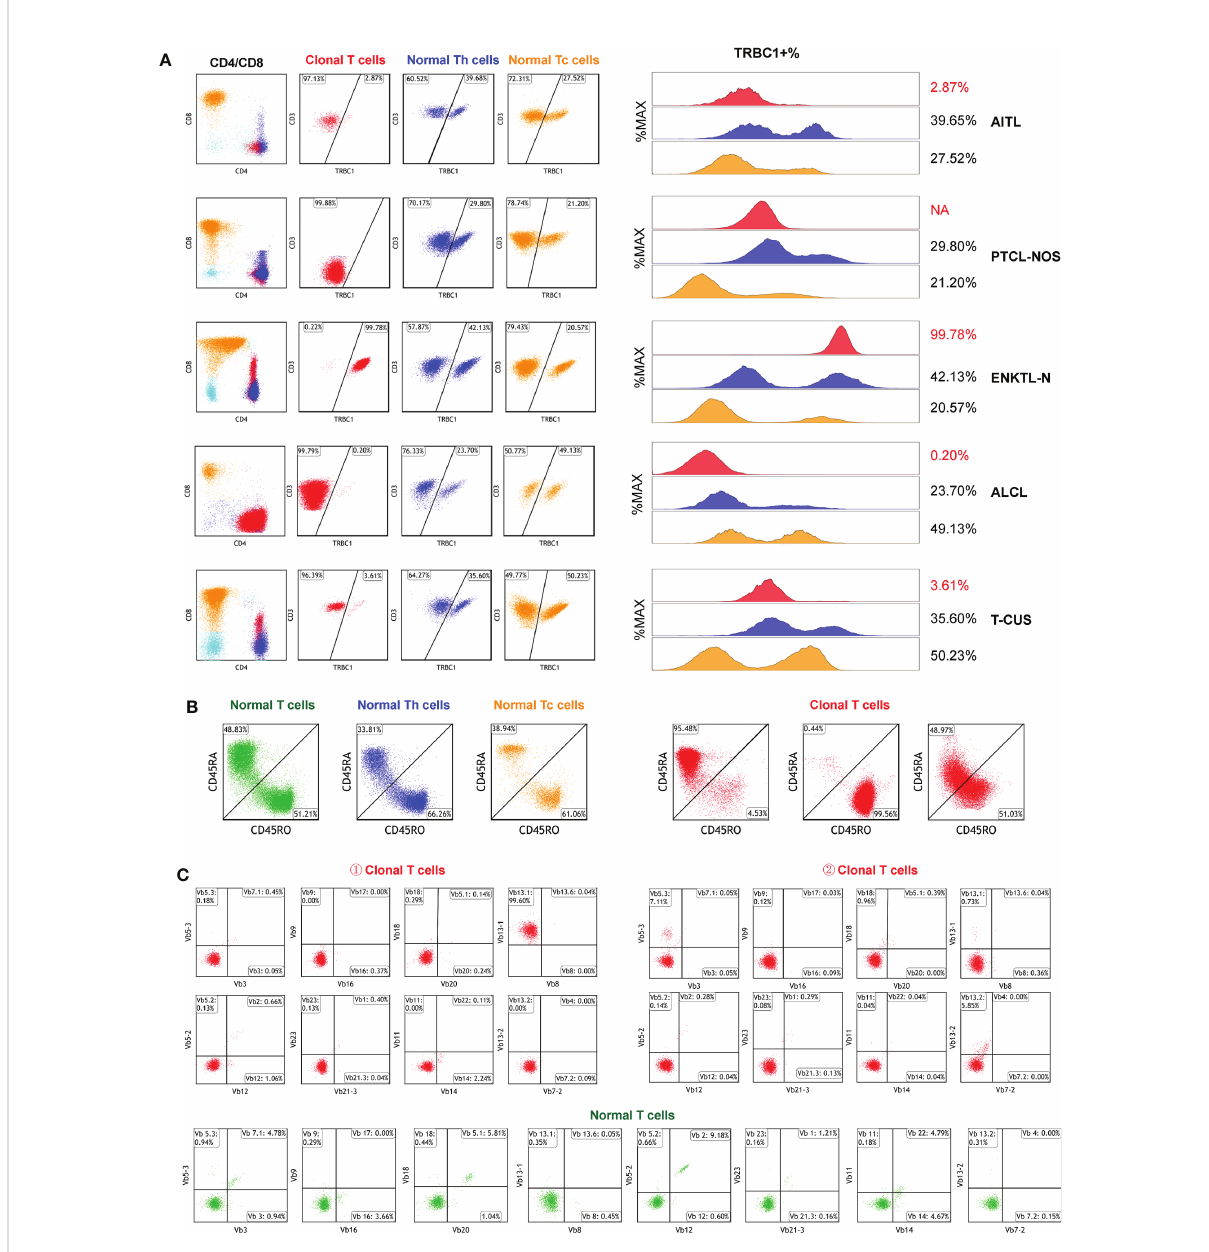
FIGURE 6 Clonal detection of T cells. (A) The clonality of each target T cell subset was detected by TRBC1. Red scatter points represent clonal T cells, blue scatter points represent background normal Th cells, and yellow scatter points represent background normal Tc cells. (B) Identi fi cation of the clonality of each target T cell subset by examining the CD45RA/CD45RO differentiation trajectories. Under normal circumstances, the differentiation trajectories of T cells are scattered and continuous, and under abnormal circumstances, they tend to aggregate into clusters. (C) Validation of T cell subset clonality by TCR- v b immunophenotype distribution. Clonal T cells are restricted to a single TCRV b subset (more than 40 – 50%), or lack